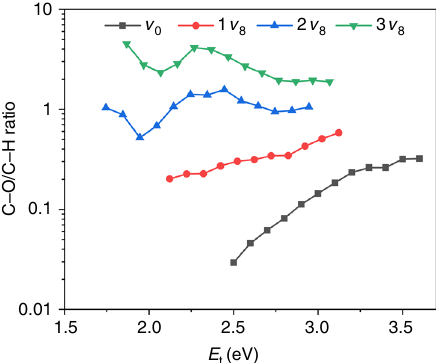
Fig. 3 Dissociation probabilities. Calculated O – H/C – H/C – O dissociation probabilities as a function of normal incidence energy of CH 3 OH( v ) on Cu (111) in its ground ( v 0 ) and fi rst excited states with O – H stretching (1 v 1 ), C – H symmetric stretching (1 v 3 ), C – H antisymmetric stretching (1 v 2 (A ′ ) and 1 v 9 (A ″ )), and three quanta overtone with C – O stretching (3 v 8 ), respectively